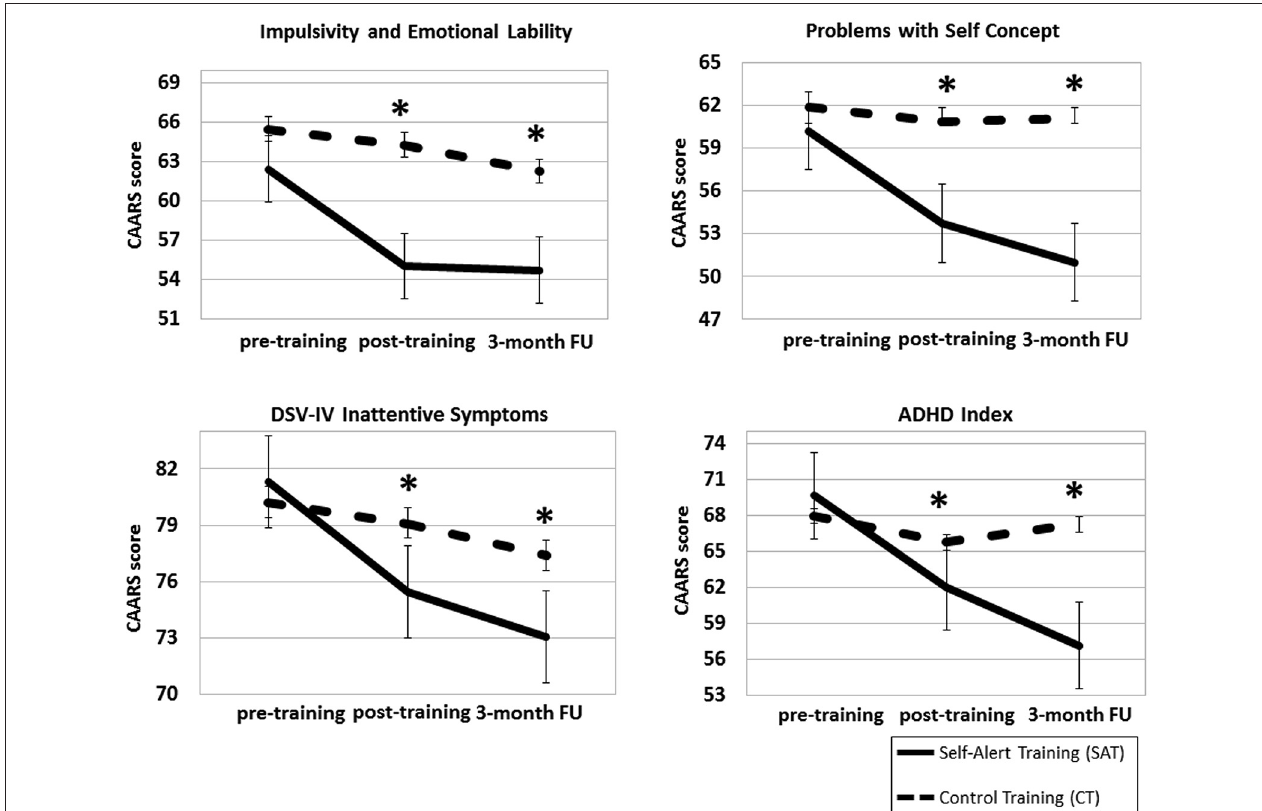
decreased ADHD symptoms compared to CT participants at post-training and after 3 months. Error bars represent standard errors. ∗ Indicates statistically significant